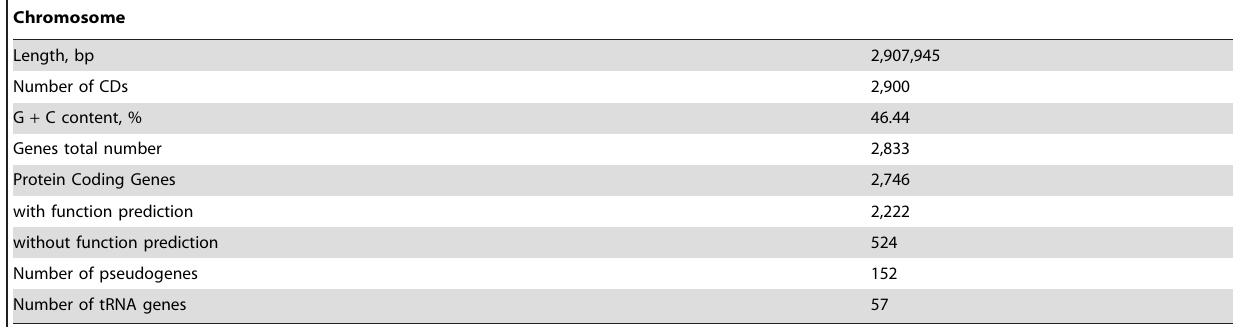
Table 1. Important features of the L. casei 12A genome.